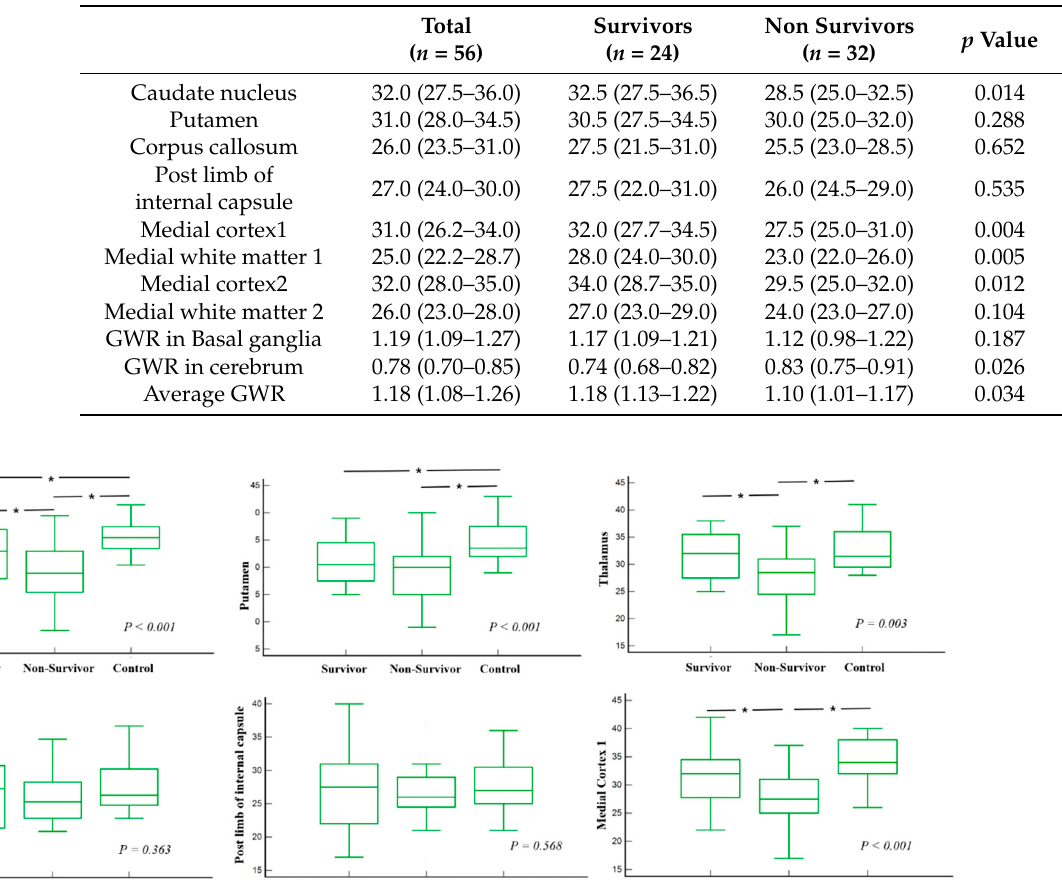
Table 2. Comparison of absolute attenuation in Hounsfield units and grey/white matter ratio between survivors and non-survivors.